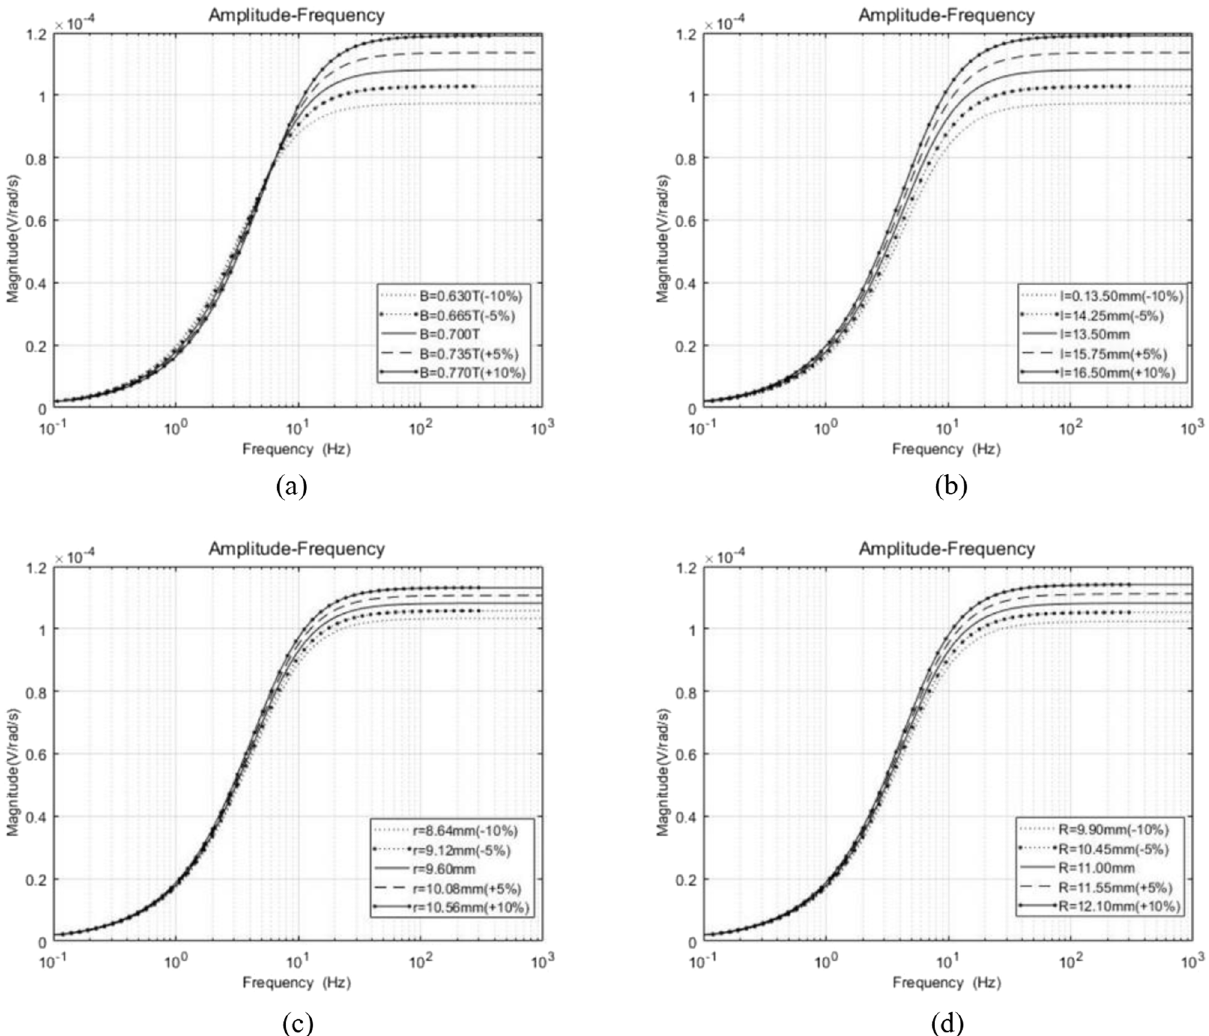
Fig. 5. The amplitude-frequency characteristic ’ s sensitivity analysis to micro adjustment of the designed parameters. (a) B adjustment; (b) l adjustment; (c) r adjustment; (d) R adjustment.